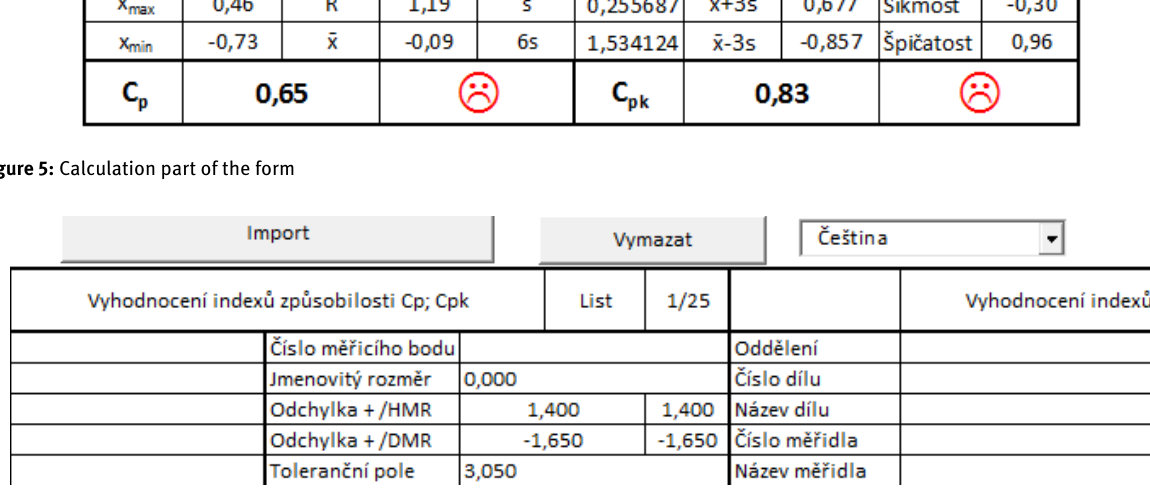
Figure 6: Calculation part of the